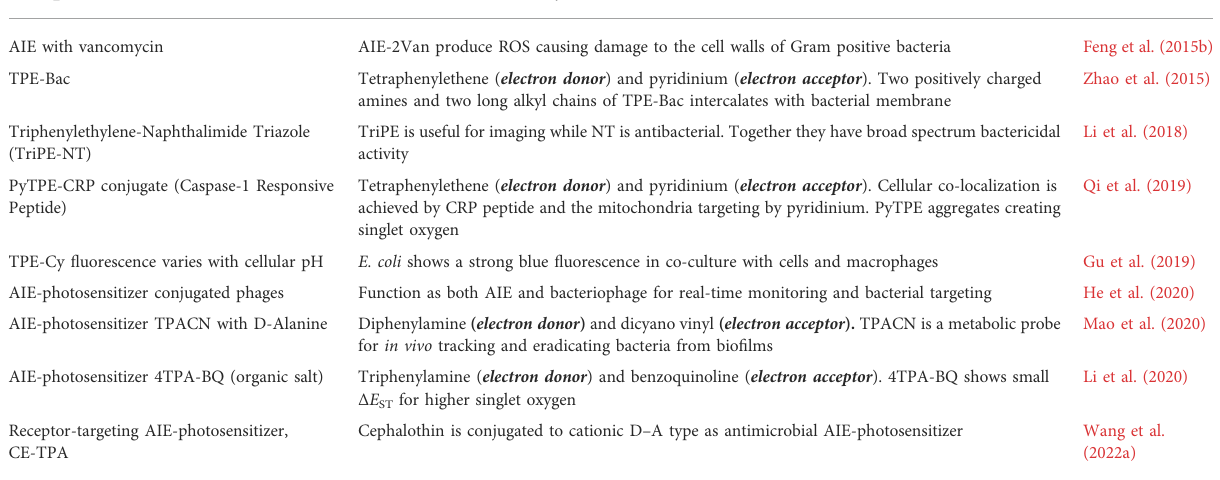
TABLE 4 AIE-photosensitizers for antimicrobial theranostics.